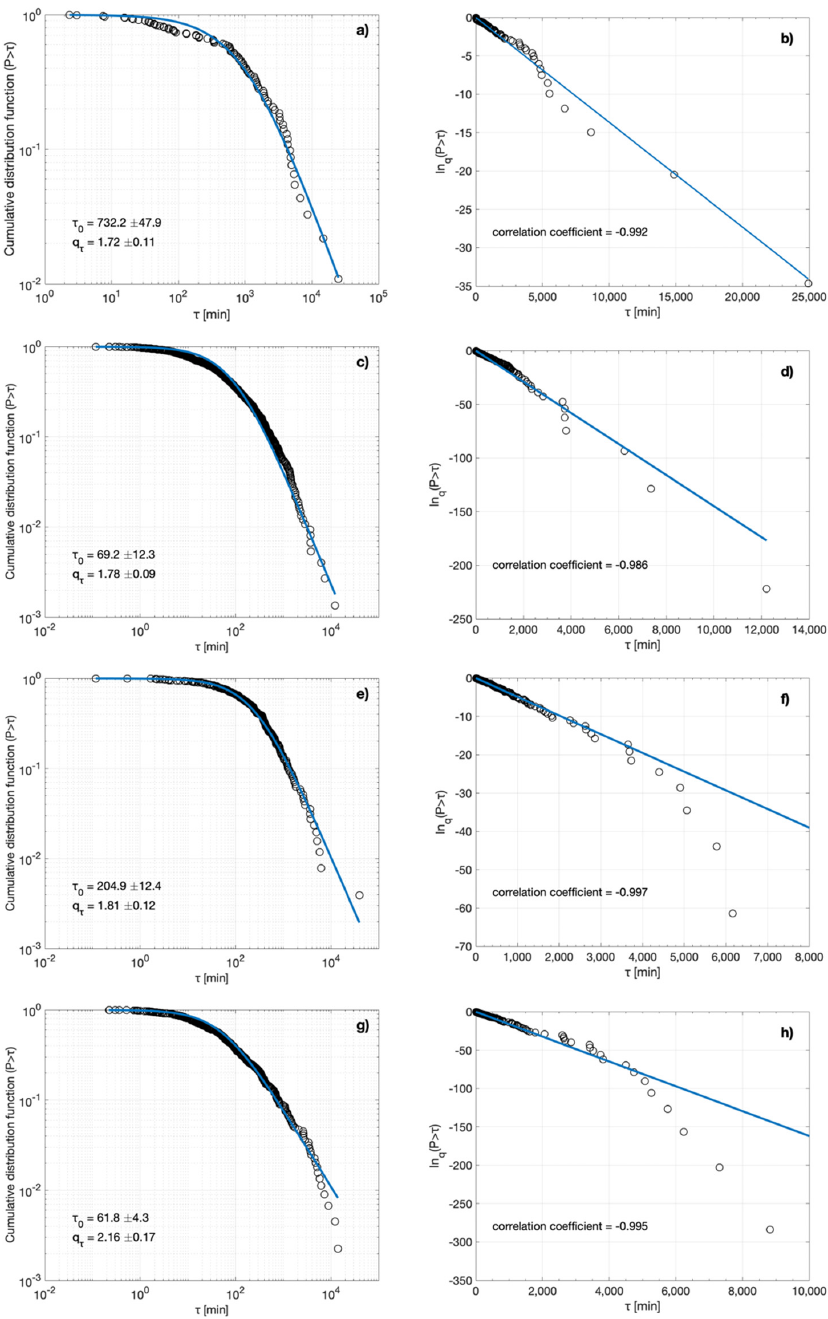
Figure 17. The cumulative distribution function P( > τ ) of the inter-event times τ (in minutes) (left panels) and the corresponding q -logarithmic function (right panels), represented by circles, for the ( a , b ) foreshock sequence, ( c , d ) aftershock sequence, ( e , f ) NE aftershocks cluster, ( g , h ) SW aftershocks cluster. Fitting with the q -exponential function (Equation (10)) is shown with the solid lines, for the parameter values and the corresponding correlation coefficients shown in the down left corners.